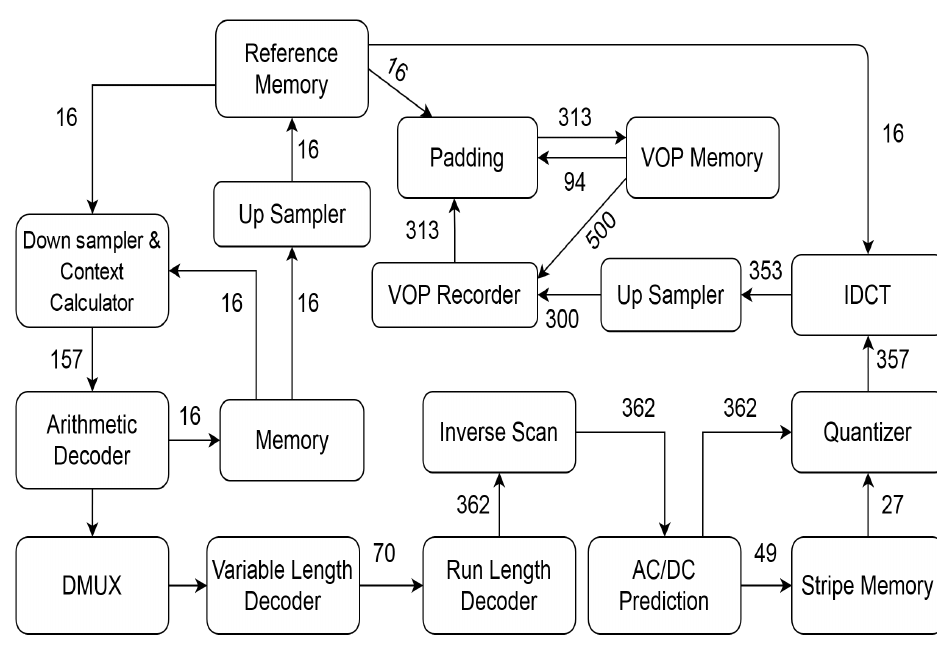
Figure 5. Architectural representation of VOPD.